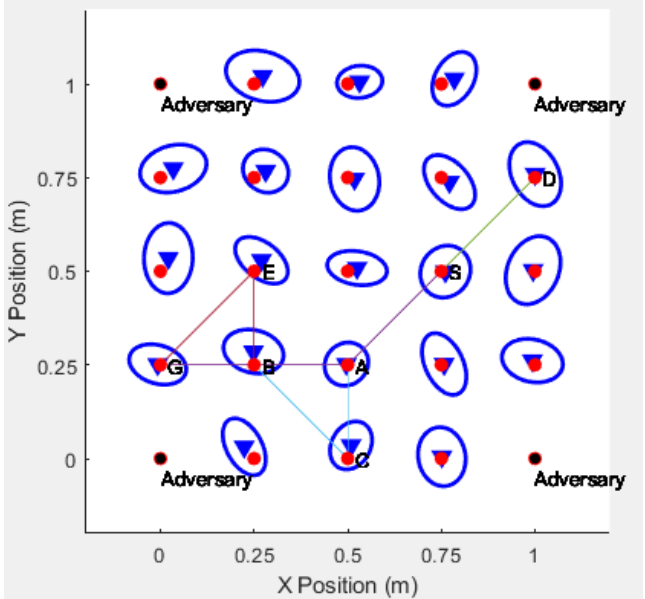
Figure 8. Real Position of Sensor Detected by